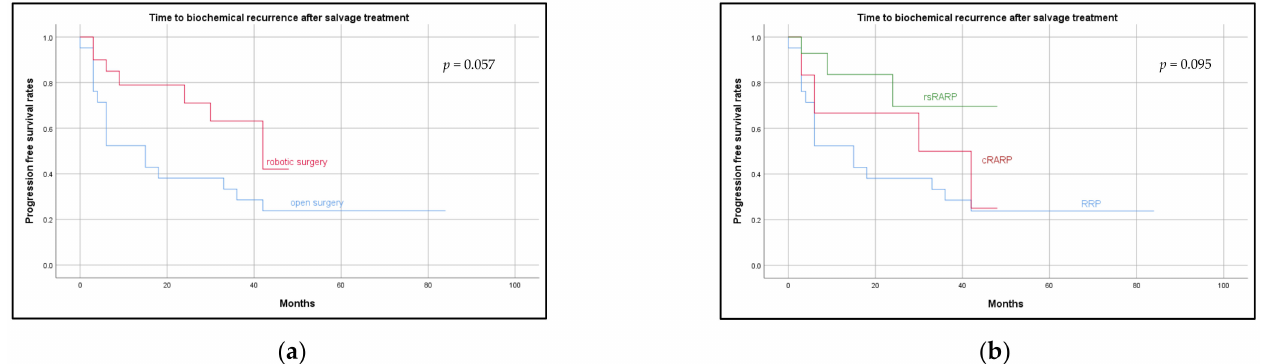
Figure 1. Time to biochemical recurrence. ( a ) Showing time to biochemical recurrence after salvage prostatectomy for open vs. robotic assisted radical prostatectomy. ( b ) Showing time to biochemical recurrence separately for open (RRP), conventional (cRARP), and Retzius-sparing (rsRARP) robotic salvage